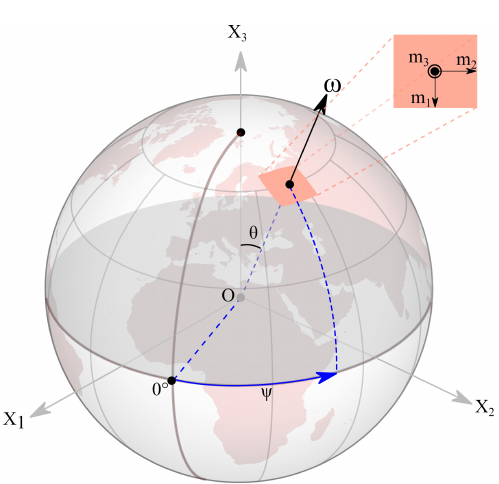
Figure A1. Terrestrial reference frame; m 1 and m 2 are the coordinates of the rotation pole, while ψ and θ are the declination and inclination, respectively, introduced by Laplace